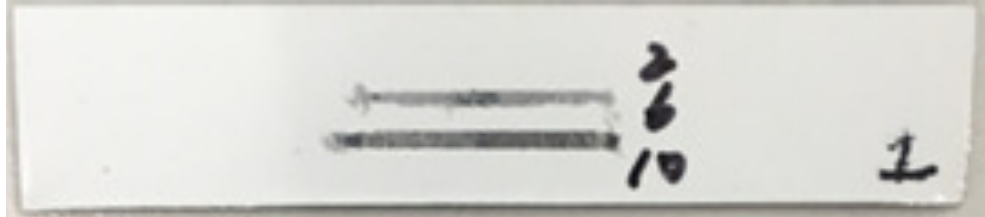
Figure 15. Wear tracks on the strip caused by forces of 2 N, 6 N and 10